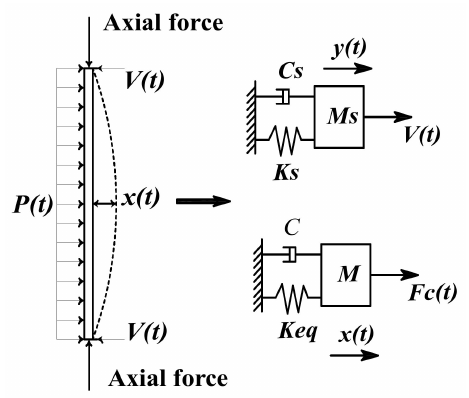
Figure 1. Bending-shear equivalent single-degree-of-freedom